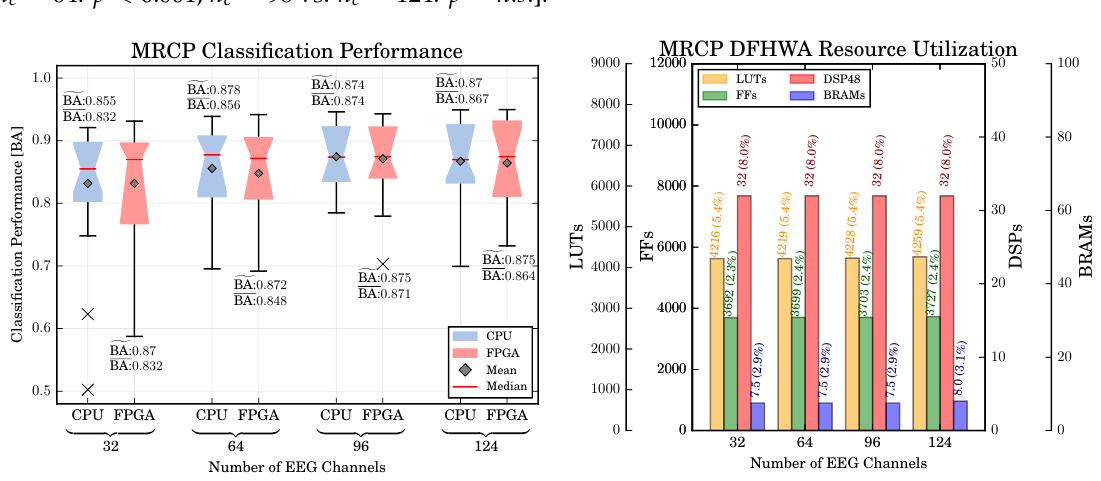
Figure 8. Left: Classification performance for the detection of the MRCP for CPU and FPGA for BA ) and mean ( BA ) classification performance is reported for each case. 32–124 channels. The median ( Right: Resource utilization of the DFHWA for different numbers of EEG channels. The percentage (cid:102) values refer to the amount of resources provided by the Zynq ZC7030.